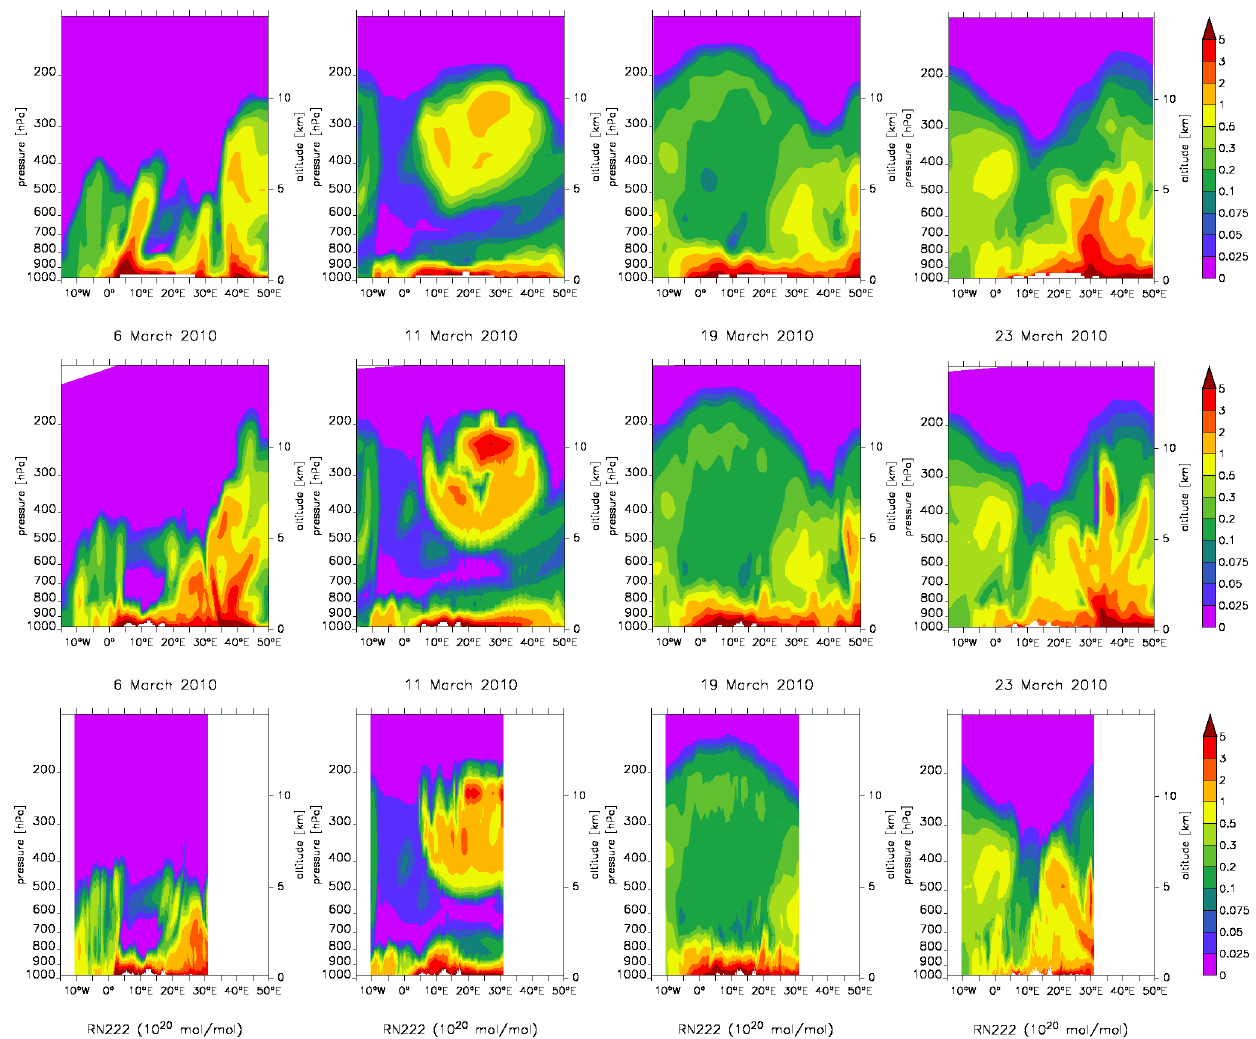
Fig. 11. Vertical cross section of Rn 222 mixing ratios at 50 ◦ N. Snapshots are taken at 6, 11, 19, 23 March, respectively. Upper row: result of the ECHAM5/MESSy simulation; middle row: COSMO-40/MESSy simulation; lower row: COSMO-7/MESSy simulation.